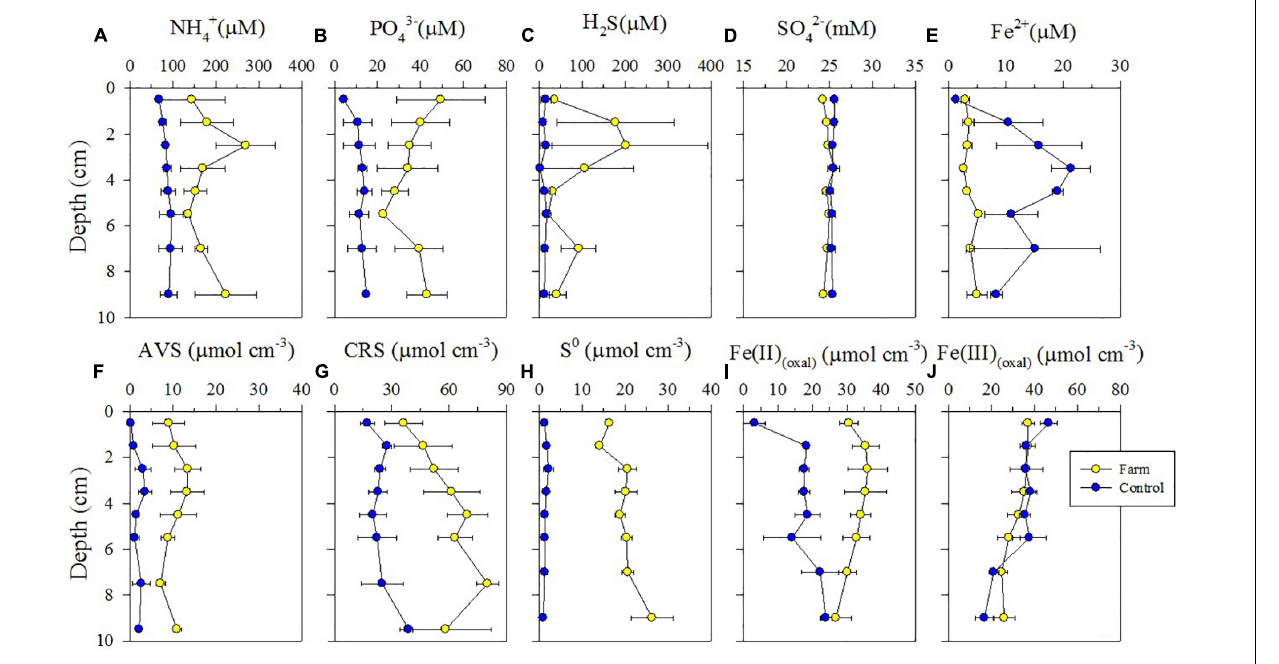
FIGURE 2 | Vertical distributions of geochemical constituents in pore water (A–E) and of AVS, CRS, S 0 , Fe(II) ( oxal ) , and Fe(III) ( oxal ) in sediment (F–J) of the farm and control sites. TABLE 4 | Depth integrated (0–10 cm) concentrations of the pore water and solid phase constituents in sediments (mmol m − 2 ).